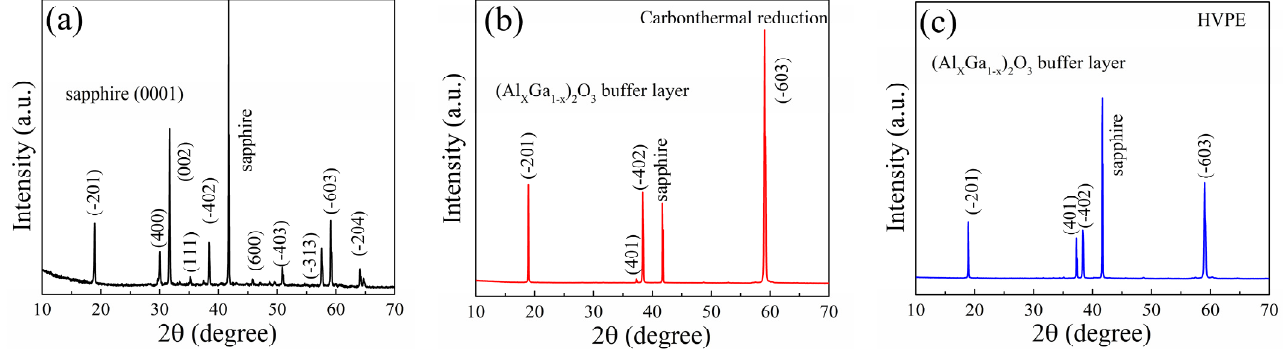
Figure 9. The XRD result of β -Ga 2 O 3 thick film grown directly on sapphire substrate ( a ). The XRD result of β -Ga 2 O 3 thick film grown on β -(Al x Ga 1 − x ) 2 O 3 /sapphire substrate by carbothermal reduction ( b ) and HVPE ( c ) methods.